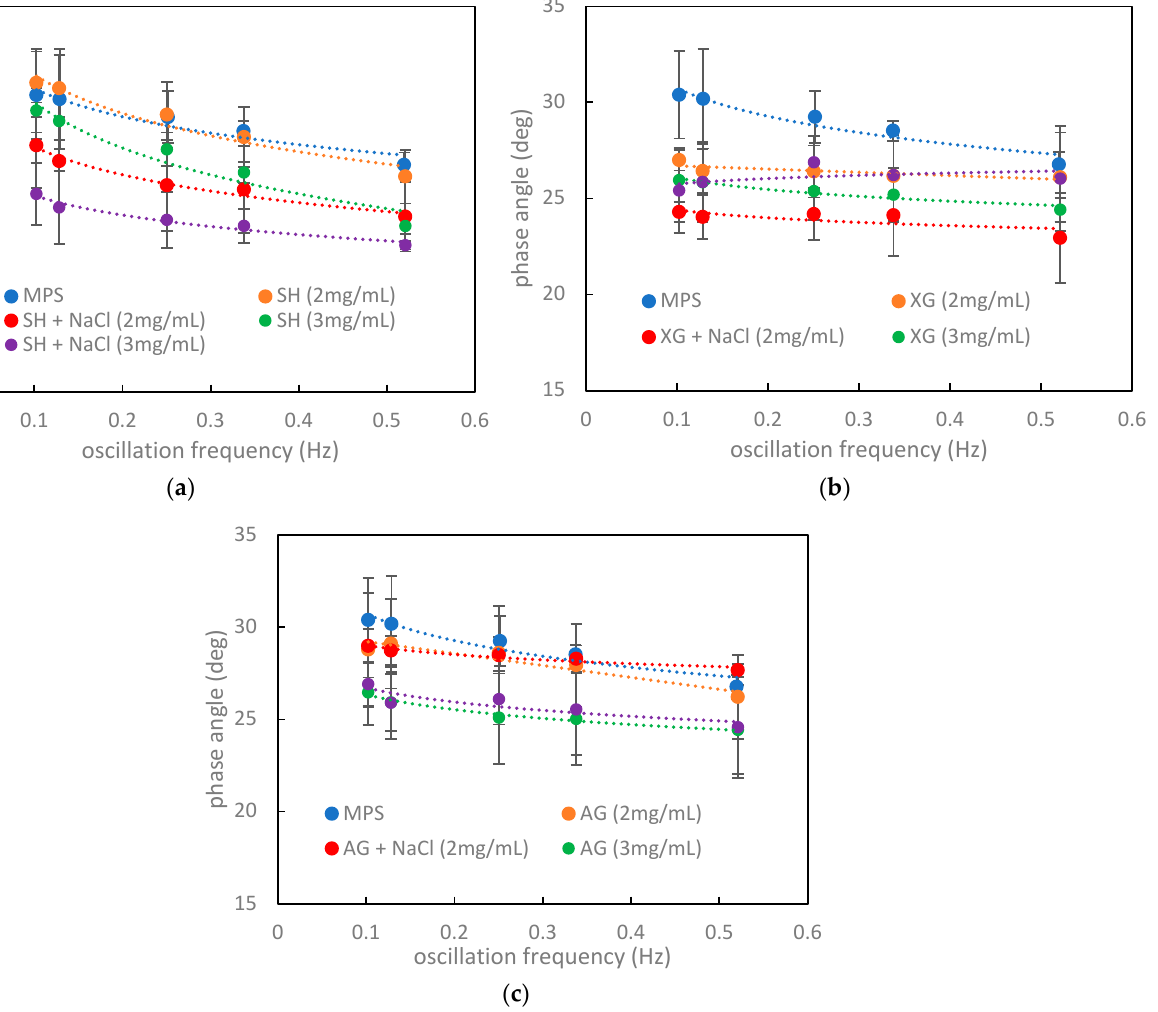
Figure 4. Phase angle ( φ ) of air–water or air–saline interface in the presence of MPS and VM: ( a ) SH, ( b ) XG, and ( c ) AG.